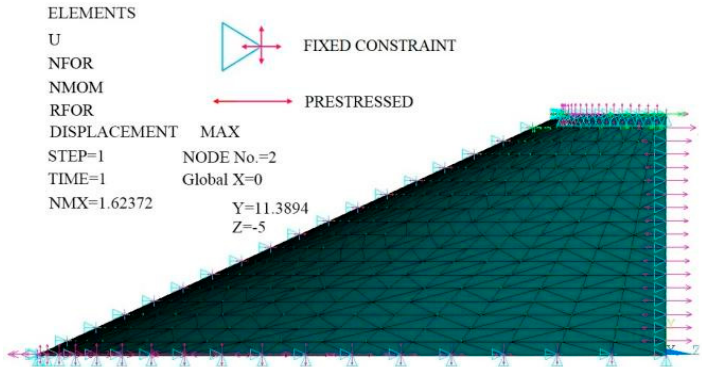
Figure 6. The schematic diagram of boundary condition loading and film deformation.